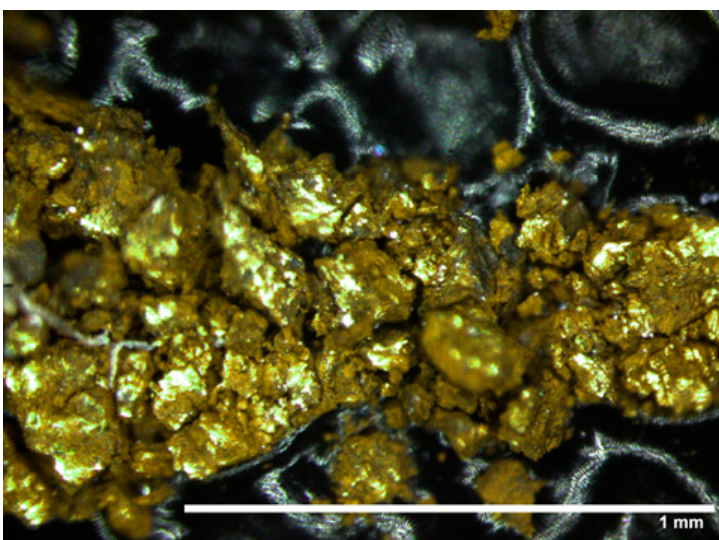
Figure 6. Zero valent gold nanoparticles obtained by sodium borohydride precipitation of the solutions resulted from the leaching with aqua regia of the gold-loaded multiwalled carbon